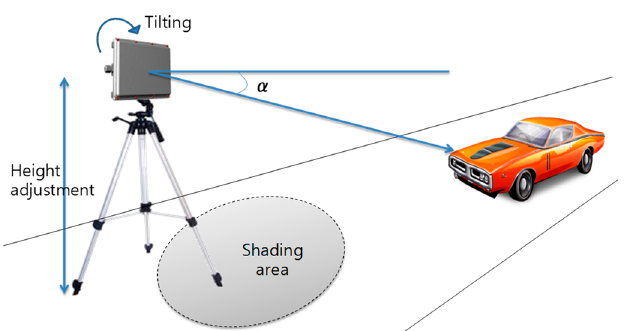
Figure 8. Radar configuration with angle ( α ) and height.